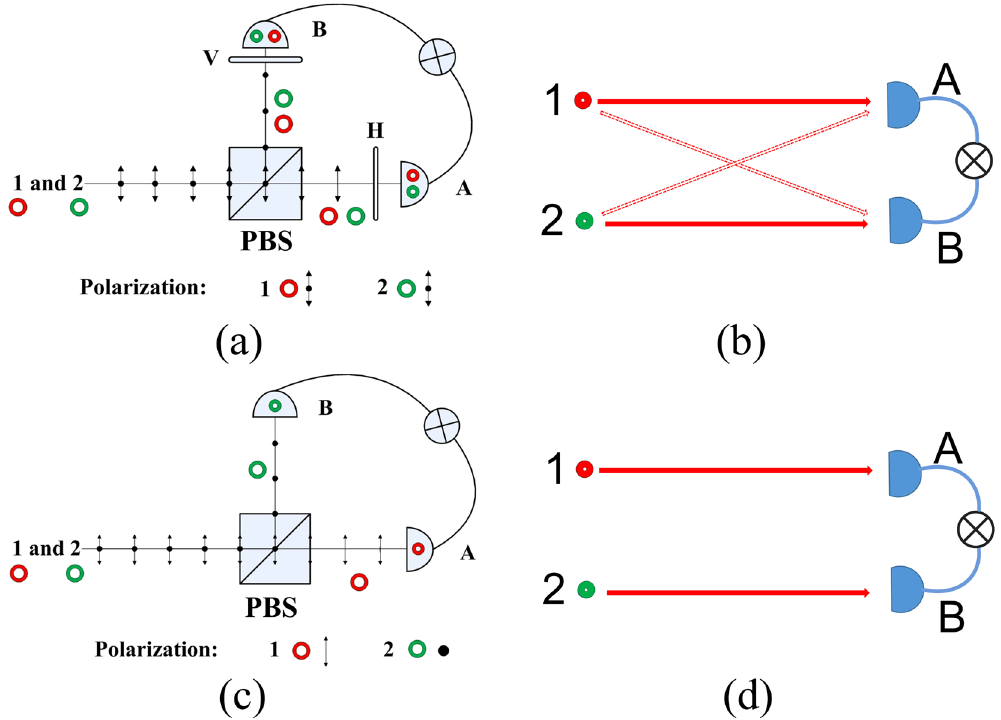
Figure 5. The difference of experiments between the HBT effect for the photons with orthogonal polarizations. ( a ) Is the scheme of experiment to certify the effect of HBT when the photons have the orthogonal polarizations. The polarization of photon 1 and 2 both are 45° with respect to horizontal polarization. ( b ) Shows the paths in which photon 1 and 2 reach the detectors. ( c ) Is the scheme in Step III of our experiment. Photon 1 with horizontal polarization only goes to detector A and photon 2 with vertical polarization only goes to detector B. ( d ) Shows only one path to trigger two-photon coincidence